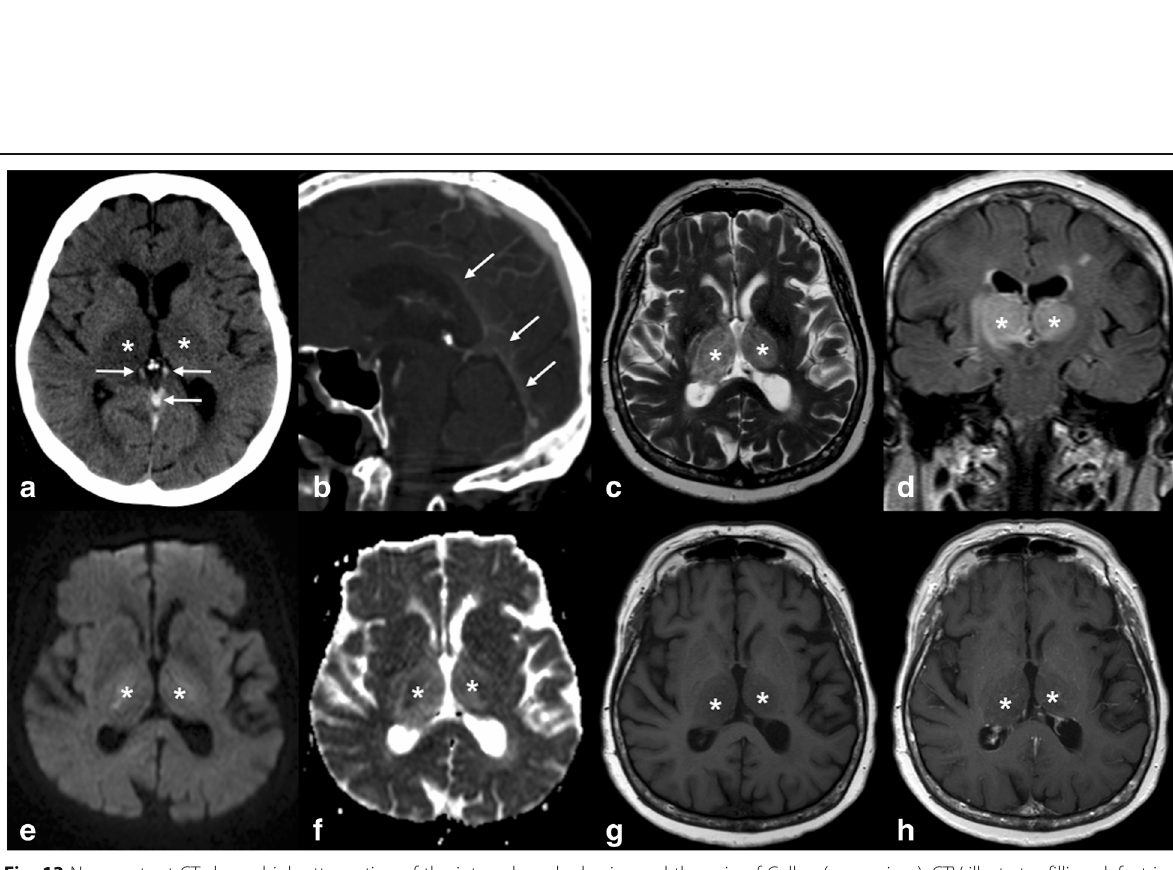
Fig. 13 Non-contrast CT shows high attenuation of the internal cerebral veins and the vein of Gallen (arrows in a ). CTV illustrates filling defect in the inferior sagittal sinus, vein of Gallen, and straight sinus (arrows in b ). Both thalami (asterisk) are hypodense on CT ( a ), hyperintense on T2 ( c ) and FLAIR ( d ), hypointense on T1 ( g ), and show no enhancement ( h ). There is no diffusion restriction ( e , f ) reflecting vasogenic oedema secondary to venous